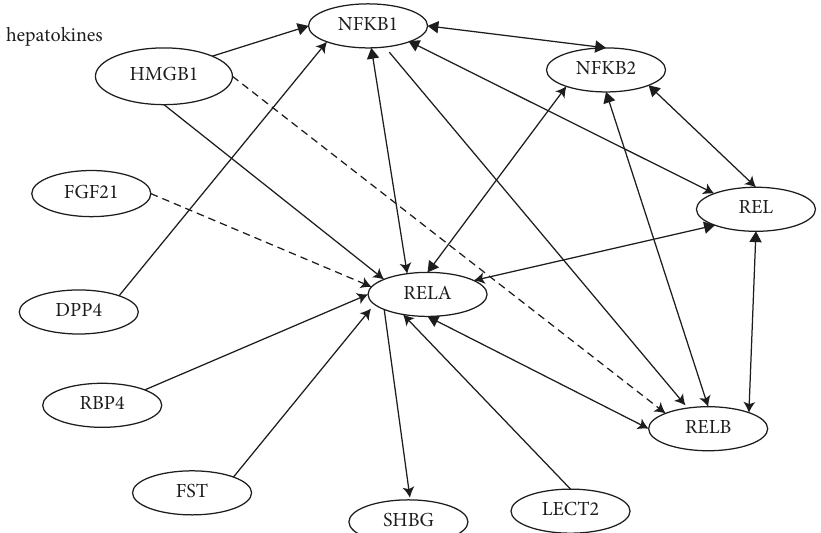
Figure 1: NF- κ B and hepatokines. IPA showed the molecular pathways of hepatokines and NF- κ B network. FGF21: fibroblast growth factor 21, HMGB1: high-mobility group box 1, DPP4: dipeptidyl peptidase 4, RBP4: binding protein 4, ASHG: alpha 2-HS glycoprotein (or FETUA), SHBG: sex hormone binding globulin, LECT2: leukocyte cell-derived chemotaxin 2, FST: follistatin. Solid lines indicate direct regulation; dashed lines indicate indirect